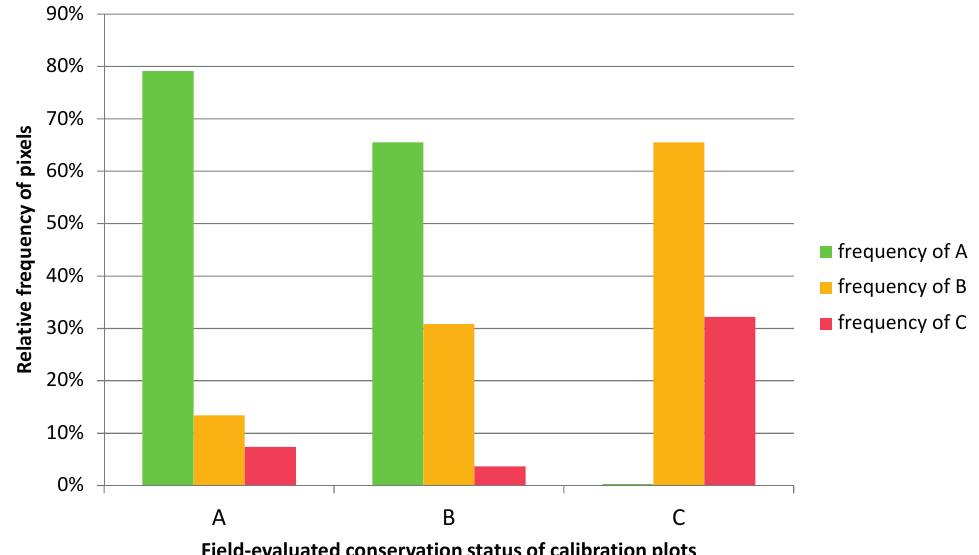
Figure 7. Frequency of 0.5 m ALS-derived pixels representing each HQ class within the summed field calibration plots of each respective